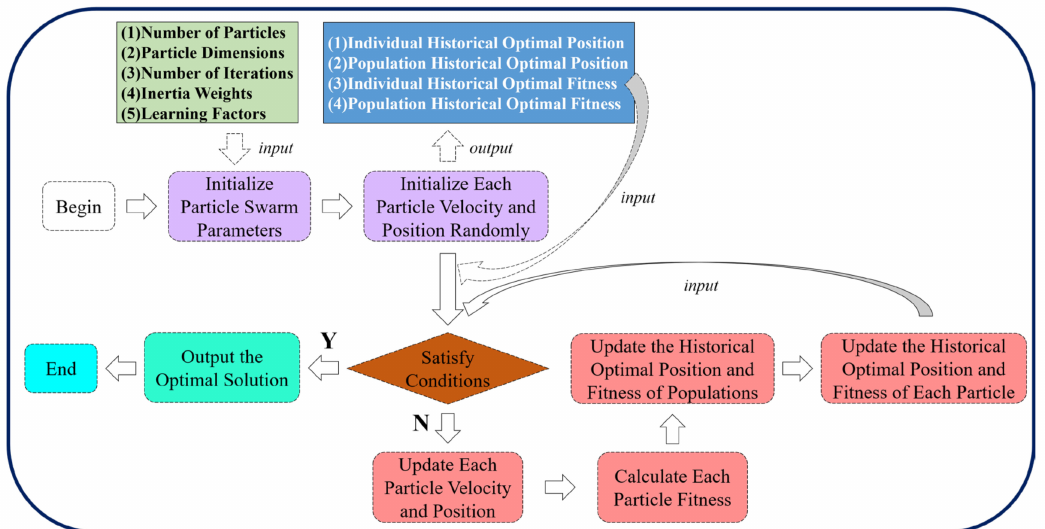
Figure 13. Search process for the PSO algorithm.